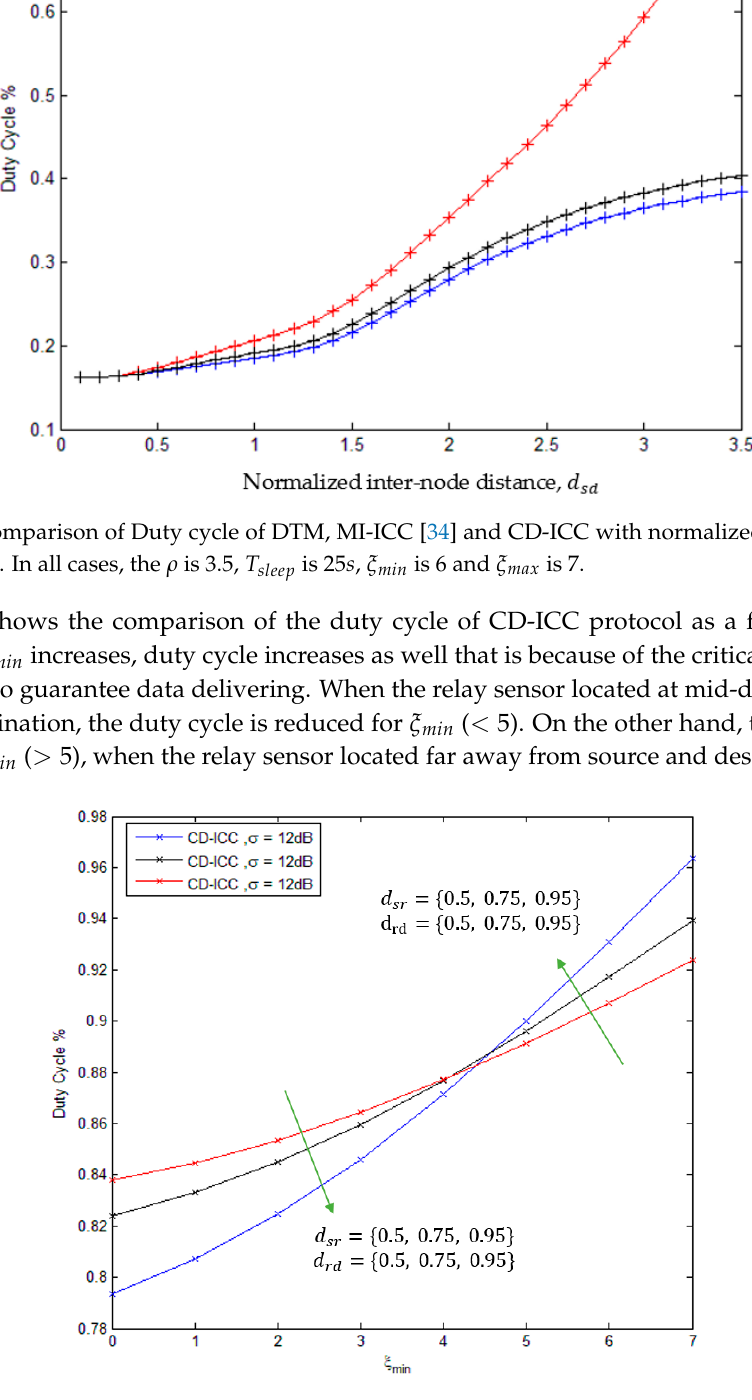
Figure 9. Comparison of average power transmission of DTM, MI-ICC and CD-ICC with normalized inter-node distance, 𝑑 (cid:3046)(cid:3031) .